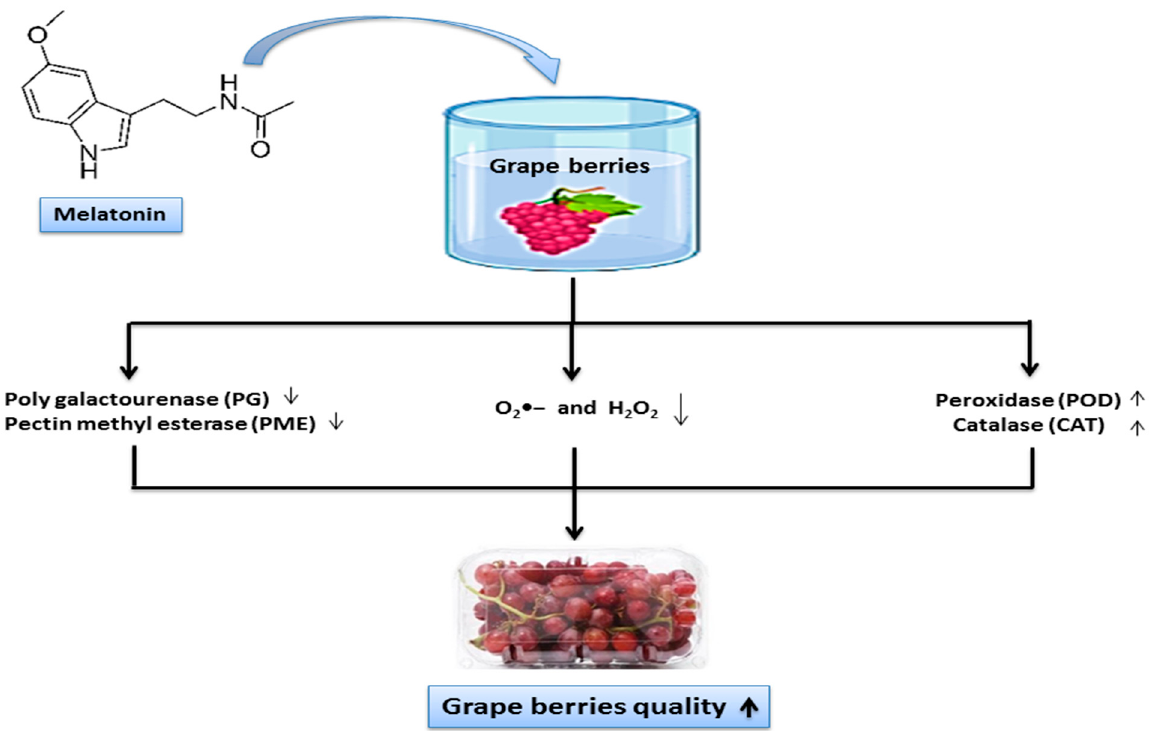
Figure 5. Simplified model for the suggested effect of melatonin on the shelf-life and storage ability of grape berries, increasing activities and synthesis of cell-wall degradation enzymes such as PG and PME, increasing activities of antioxidant enzymes (POD and CAT), which mitigate O 2 •− and H 2 O 2 rates.